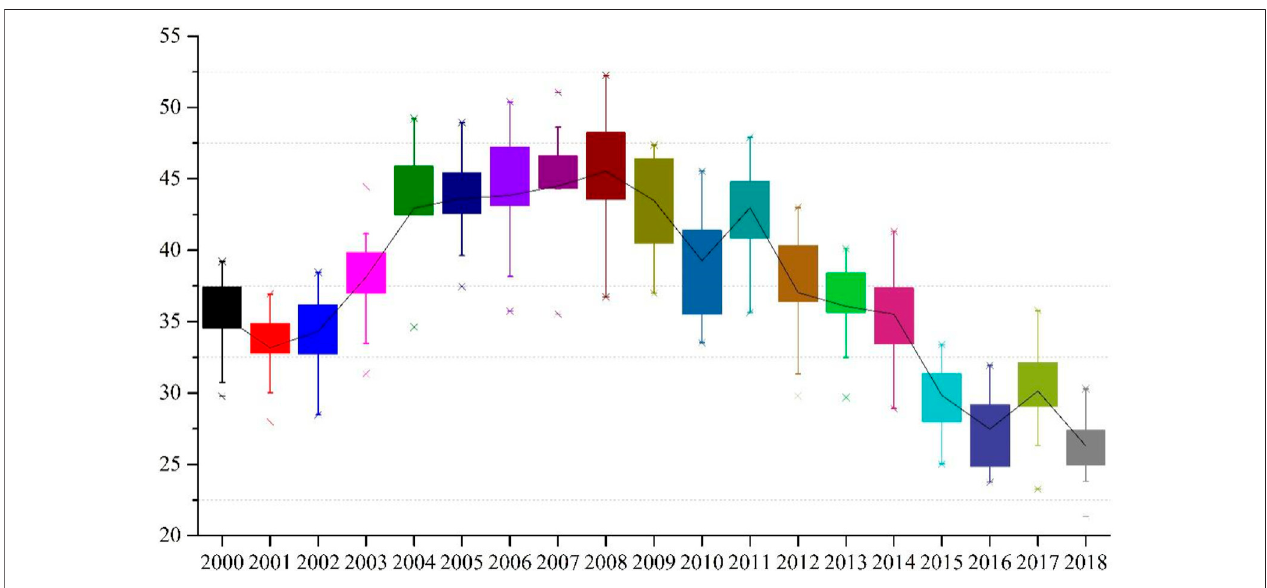
FIGURE 2 | Interannual variation of PM 2.5 concentration in the Pearl River Delta from 2000 to 2018.